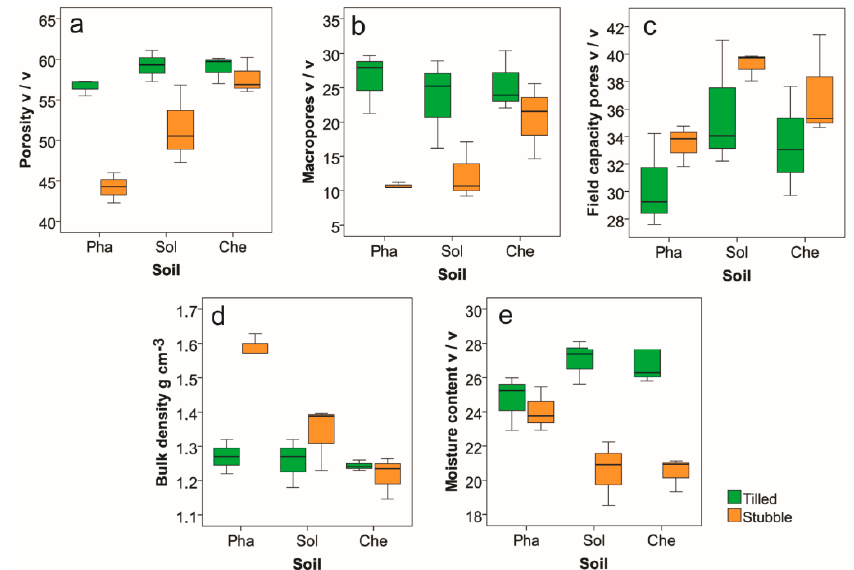
Figure 2. Differential porosity and moisture content values after seedbed preparation and under stubble conditions. Pha: Phaeozem; Sol: Solonetz; Che: Chernozem. ( a ) porosity, ( b ) volume of macropores, ( c ) volume of field capacity pores, ( d ) bulk density, ( e ) moisture content